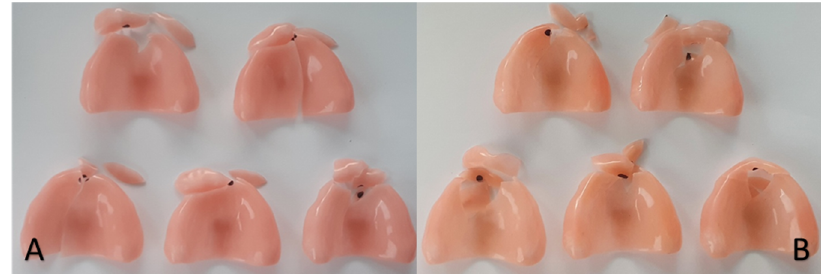
Figure 8. ProBase Cold ® ( A ) and ProBase Hot ® ( B ).